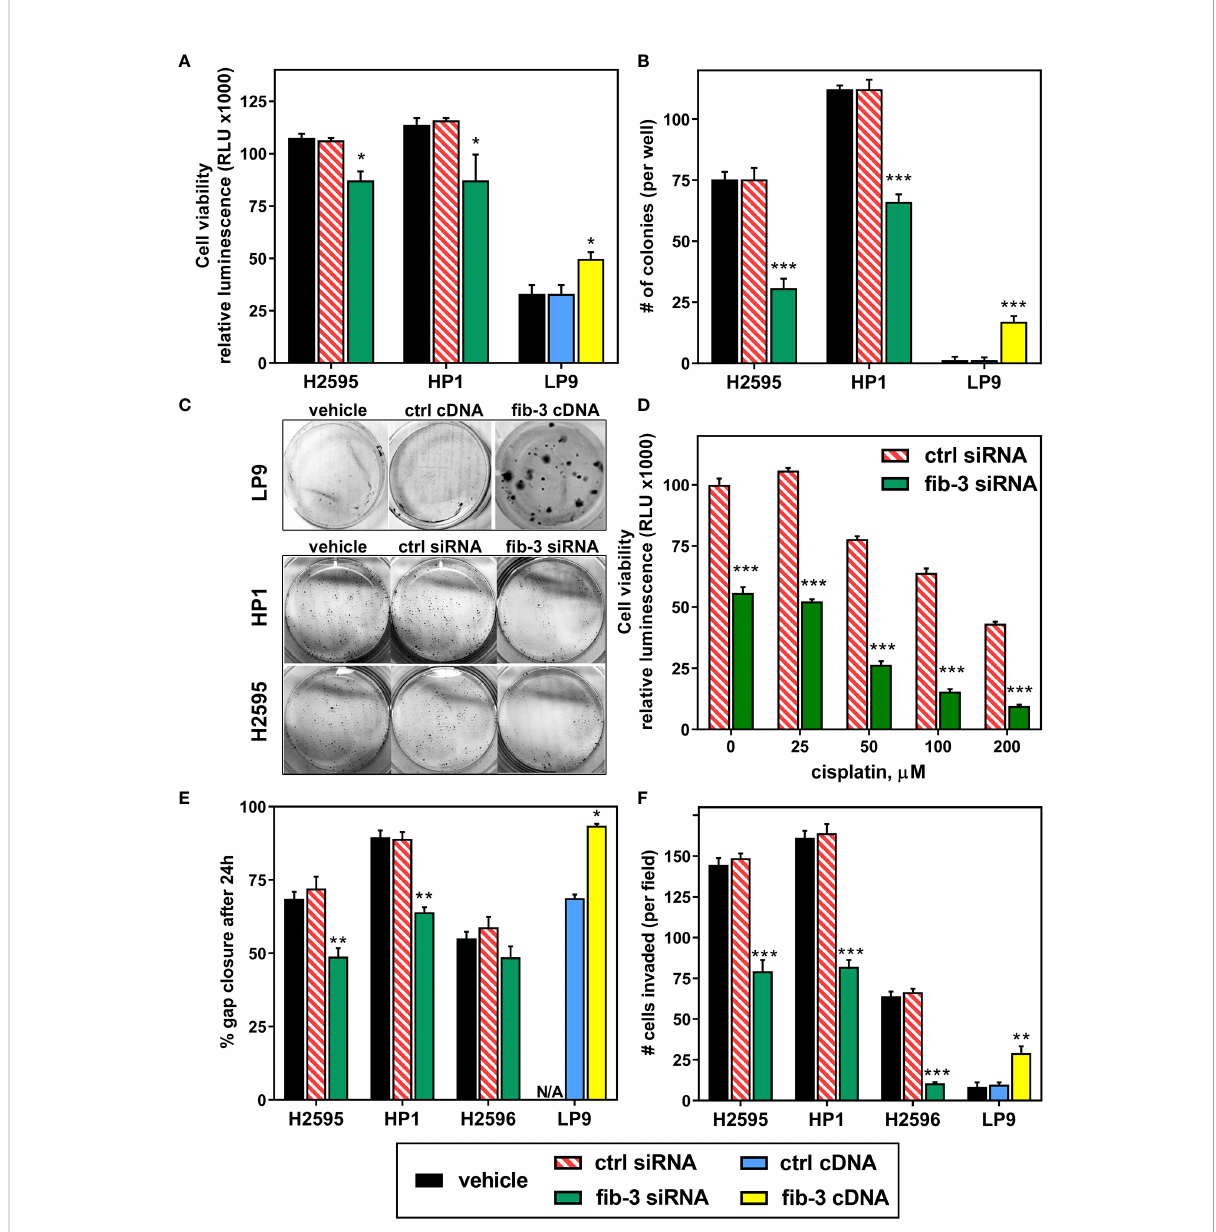
FIGURE 2 Fibulin-3 promotes MPM cell viability and invasion . (A) Fibulin-3 ( fi b-3 ) knockdown in MPM cells (H2595 and HP1) reduced cell viability, whereas fi bulin-3 overexpression in normal mesothelial cells (LP-9) increased it. (B, C) The same effects were observed on the clonogenicity of MPM and mesothelial cells after knockdown or overexpression of fi bulin-3, respectively. (D) Transient knockdown of fi bulin-3 in H2595 cells signi fi cantly increased their sensitivity to cisplatin. (E-F) Fibulin-3 de fi ciency also reduced the two-dimensional migration (E) and three-dimensional invasion (F) of H2595 and HP1 cells, as well as invasion of H2596 cells. Overexpression of fi bulin-3 in LP-9 cells achieved the opposite effects ( N/A, not assayed). Results were analyzed by 1-way ANOVA for each cell line (A, B, E, F) or two-way ANOVA (cisplatin x transfection) for